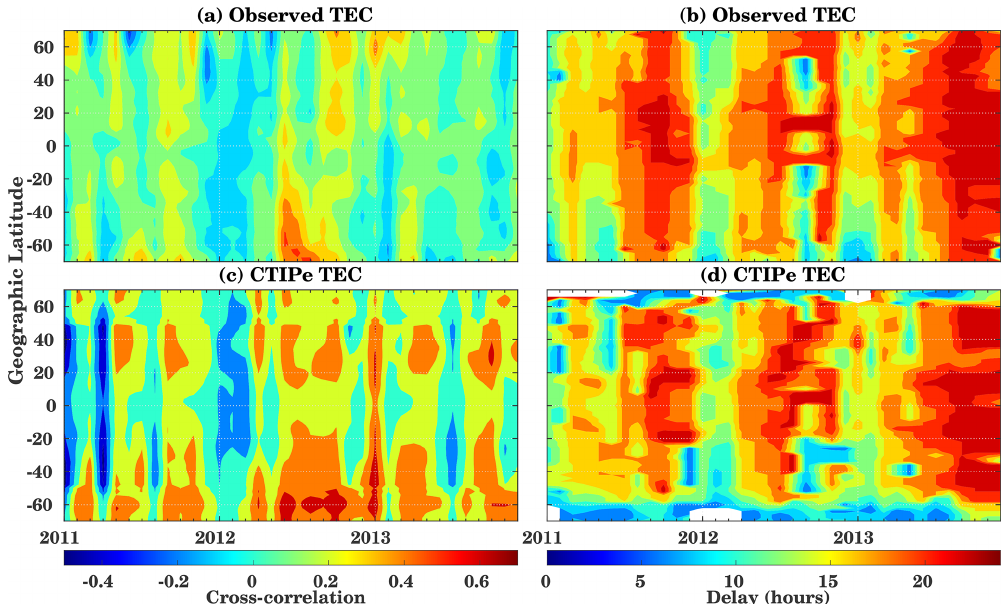
Figure 6. Correlation coefficient (a, c) and delay estimation (b, d) using observed (a, b) and model-simulated (c, d) hourly TEC and SDO EVE-integrated flux (1–120nm).